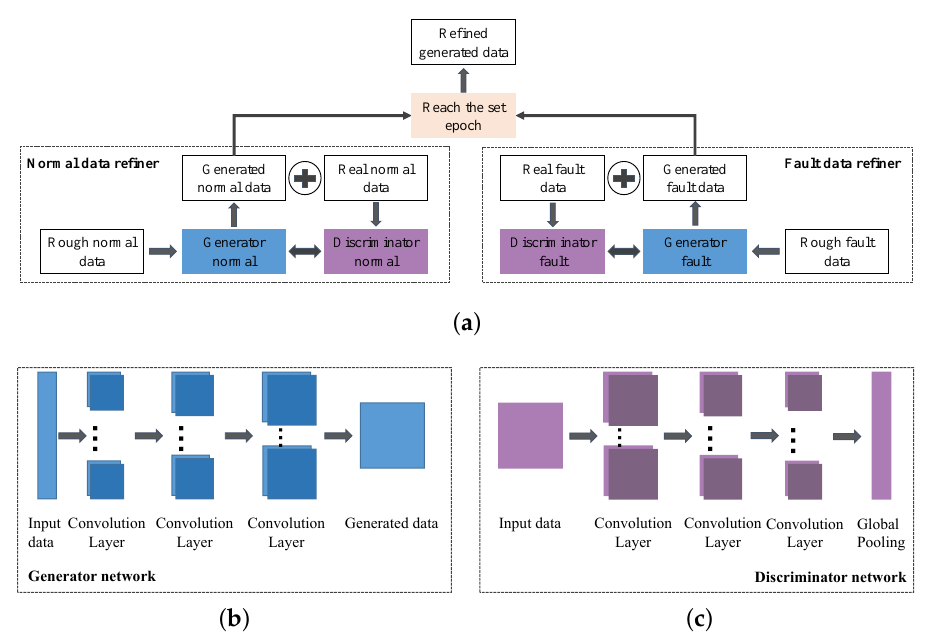
Figure 7. The architecture of data refiner: ( a ) the basic architecture of DCGAN-based nor- mal data refiner and fault data refiner; ( b ) structure of generator networks; ( c ) structure of discriminator